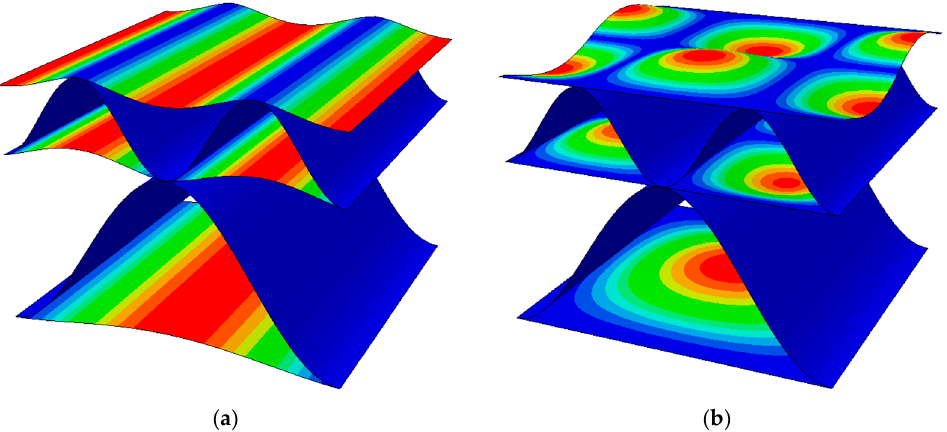
Figure 3. Imperfection shapes of double-walled corrugated board corresponding to ( a ) compression in the MD; ( b ) compression in the CD.